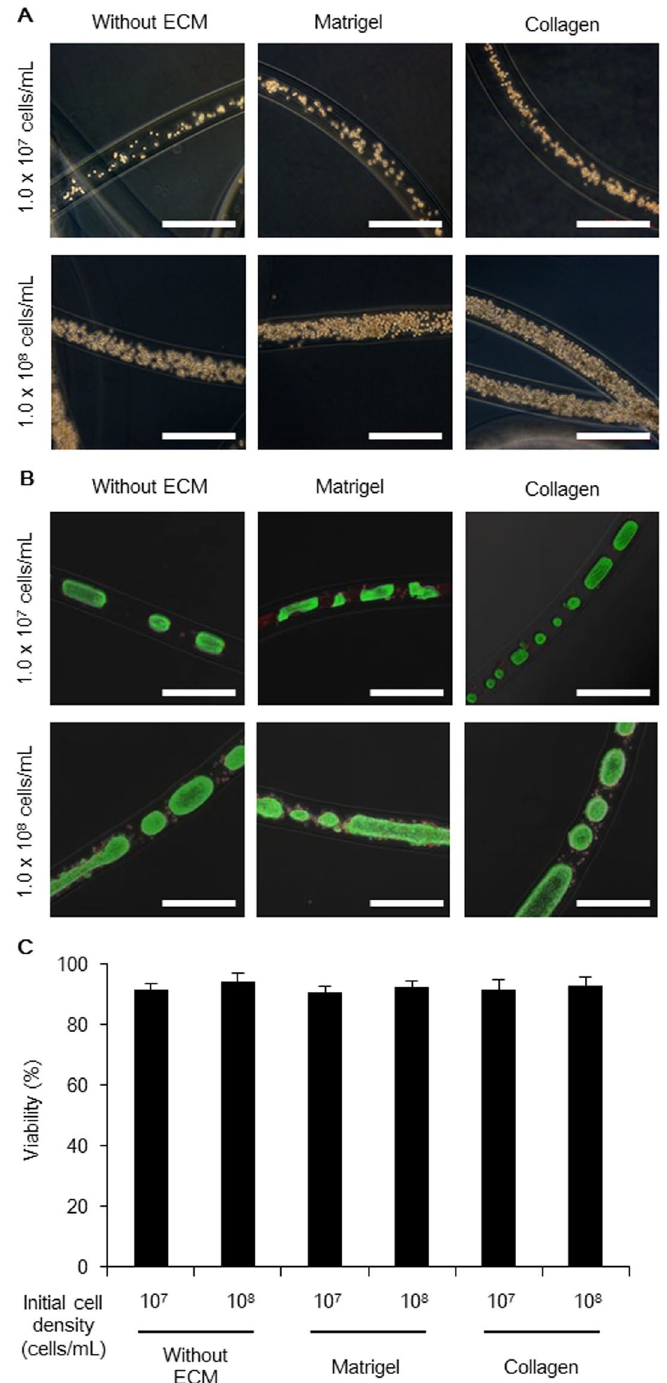
Figure 3. Human iPS cells cultured in various types of core-shell microfibers. ( A ) Phase-contrast images showing the different types of human iPS cell-laden core-shell microfibers immediately after fabrication (day 0). Scale bar: 500 μ m. ( B ) Merged phase-contrast and fluorescence images of the six types of core-shell microfibers cultured by day 4. Live cells were stained with calcein AM (green) and dead cells were stained with ethidium homodimer-1 (red). Scale bar: 500 μ m. ( C ) Viability of the cells cultured in the six types of microfibers after the retrieval of cell aggregations from the microfibers and dissociation into single cells on day 4 (N ≥